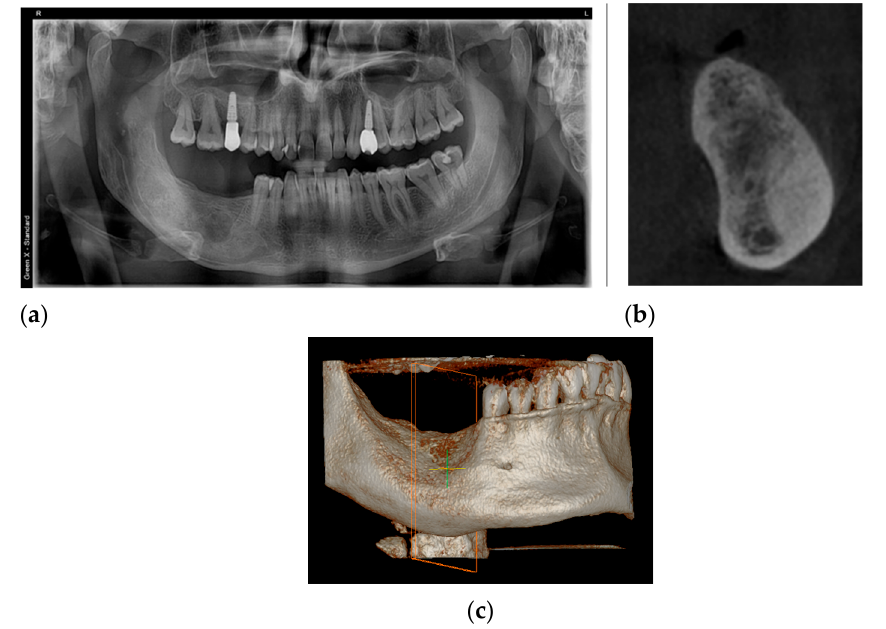
Figure 11. The aspect of the healing process, two years after recurrence surgery: ( a ) orthopantomog- raphy image; ( b ) cone-beam computerized tomography image; ( c ) the CBCT, 3D reconstruction view.